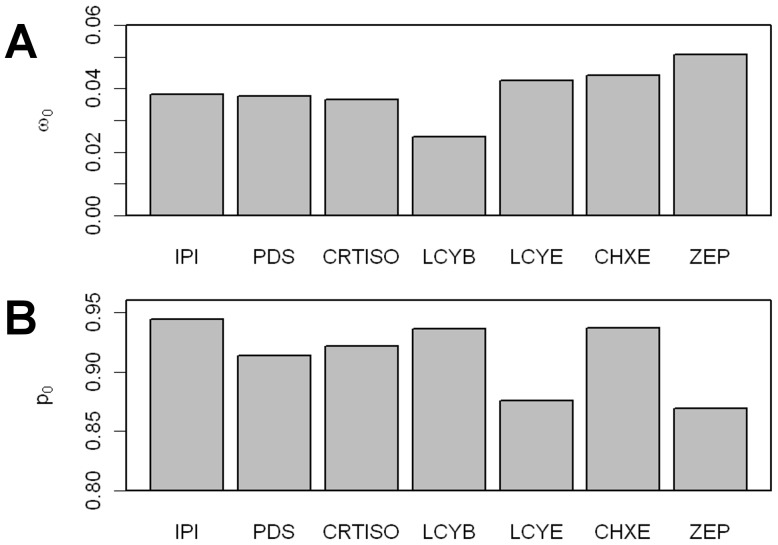
Constraint relaxation in the carotenoid biosynthesis pathway.(A) ω0 and (B) ratio of codons with 0<ω
0<1 (p0) are displayed as a function of carotenoid biosynthesis pathway genes. Values shown were estimated by the M1a model calculated by CODEML [65]. The genes are sorted according to their pathway position.